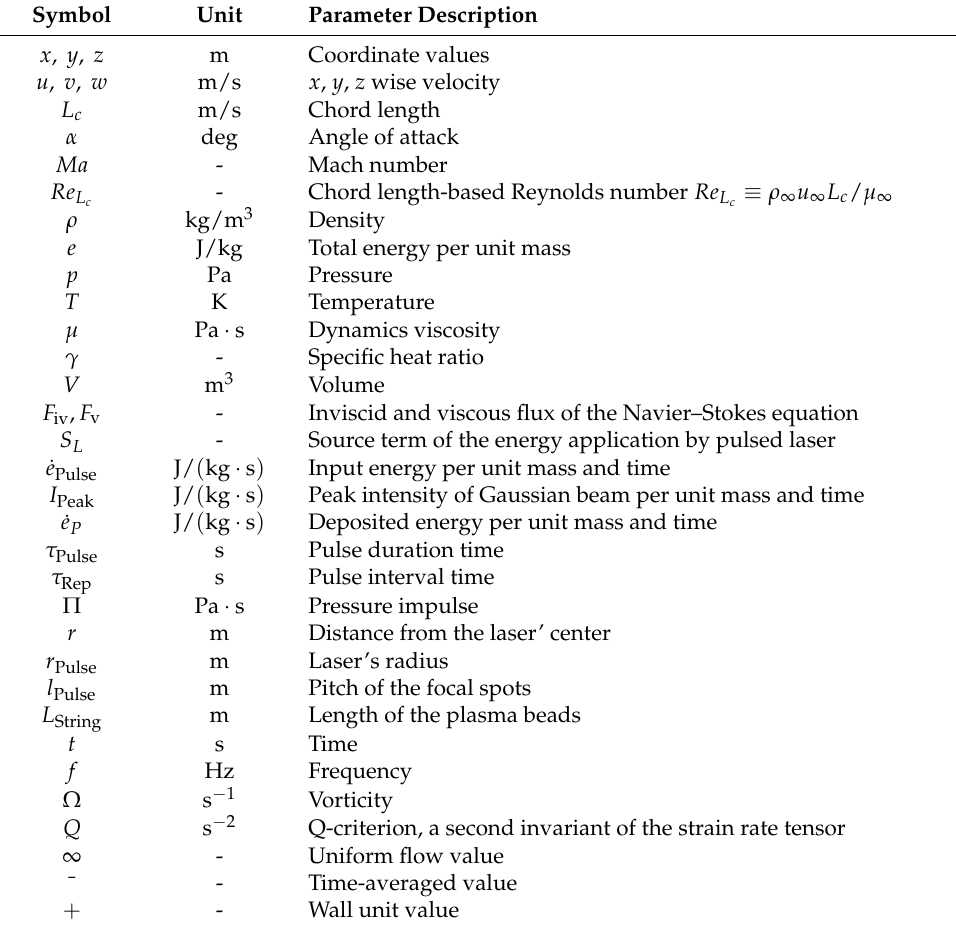
Table A1. Physical quantity symbols and units in this